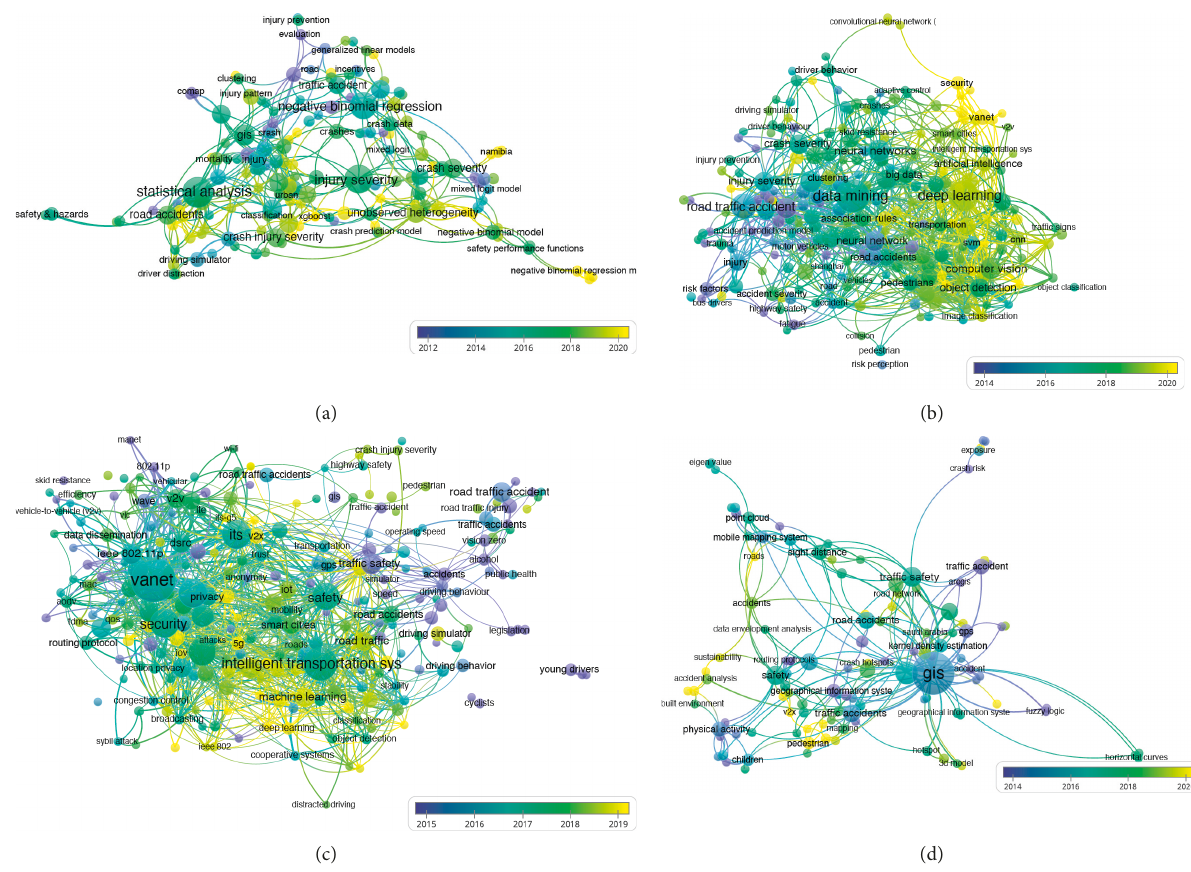
Figure 3: Wordclouds of the main analytical methods used for analyzing road traffic accidents in the (a) RTA +HA+SM, (b) RTA+HA +ML, (c) RTA +HA+SC, and (d) RTA +HA+ GIS